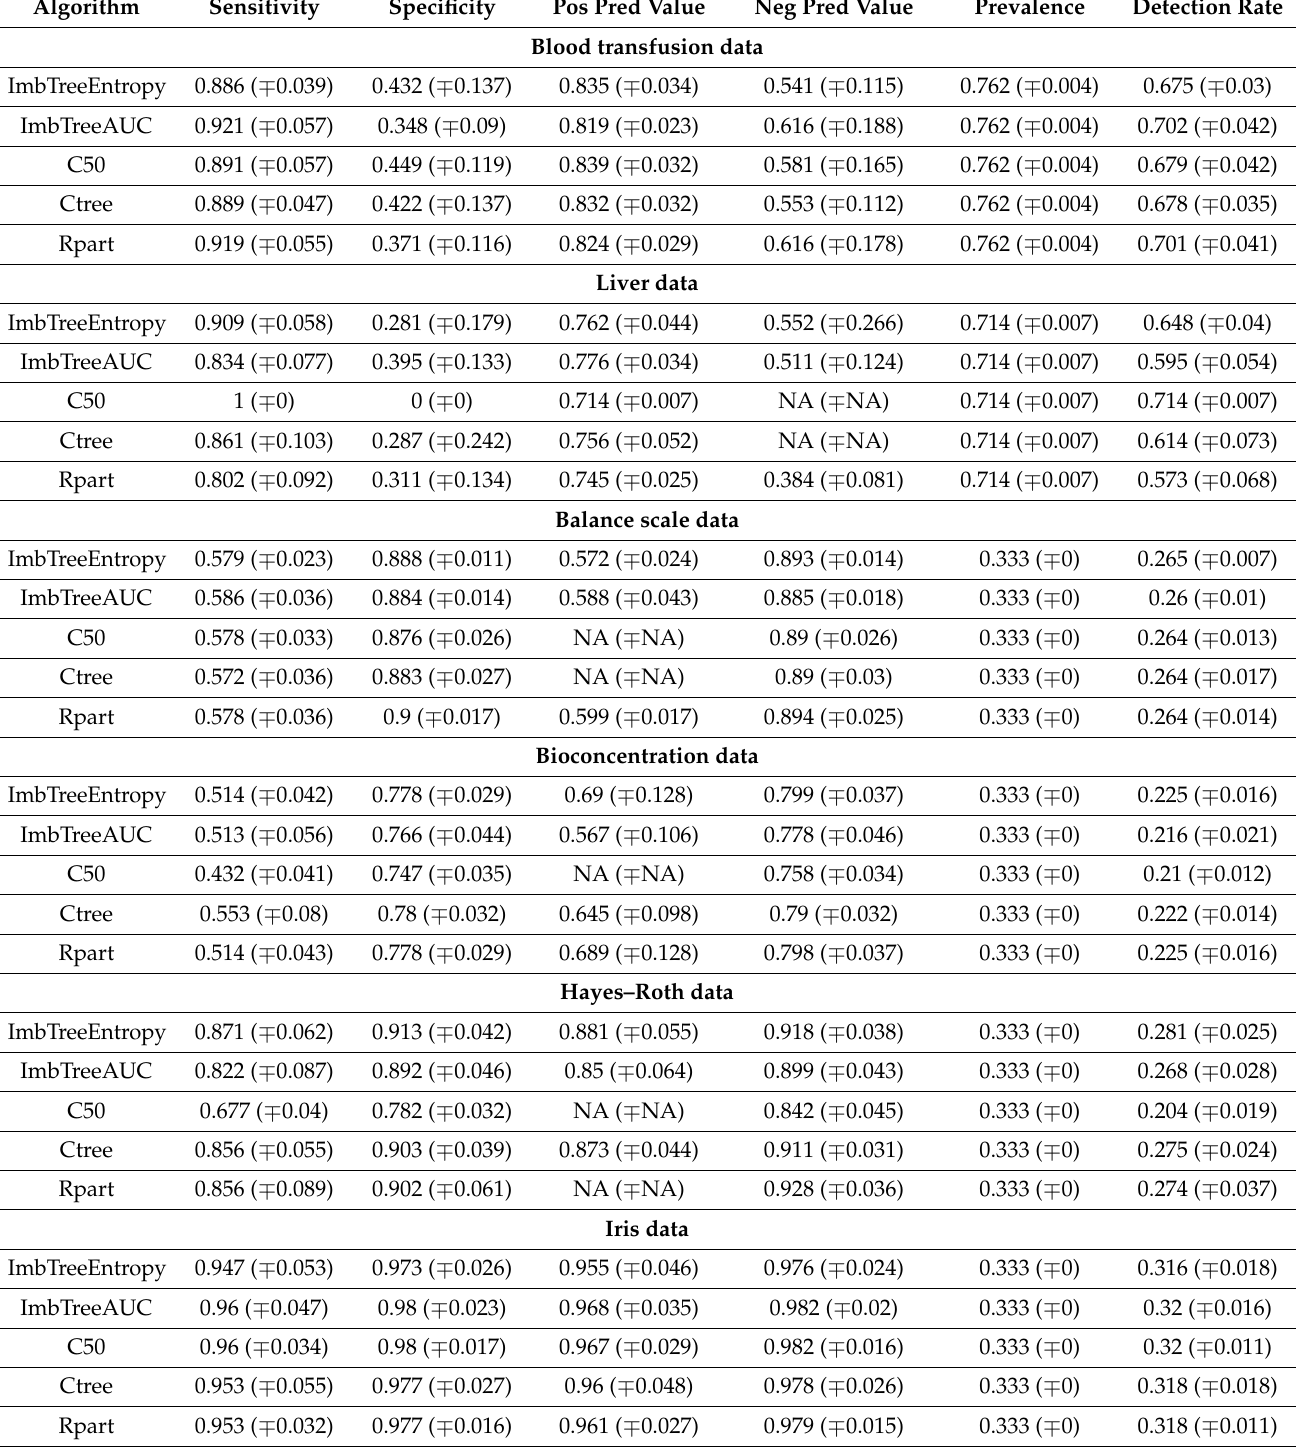
Table A1. Additional performance